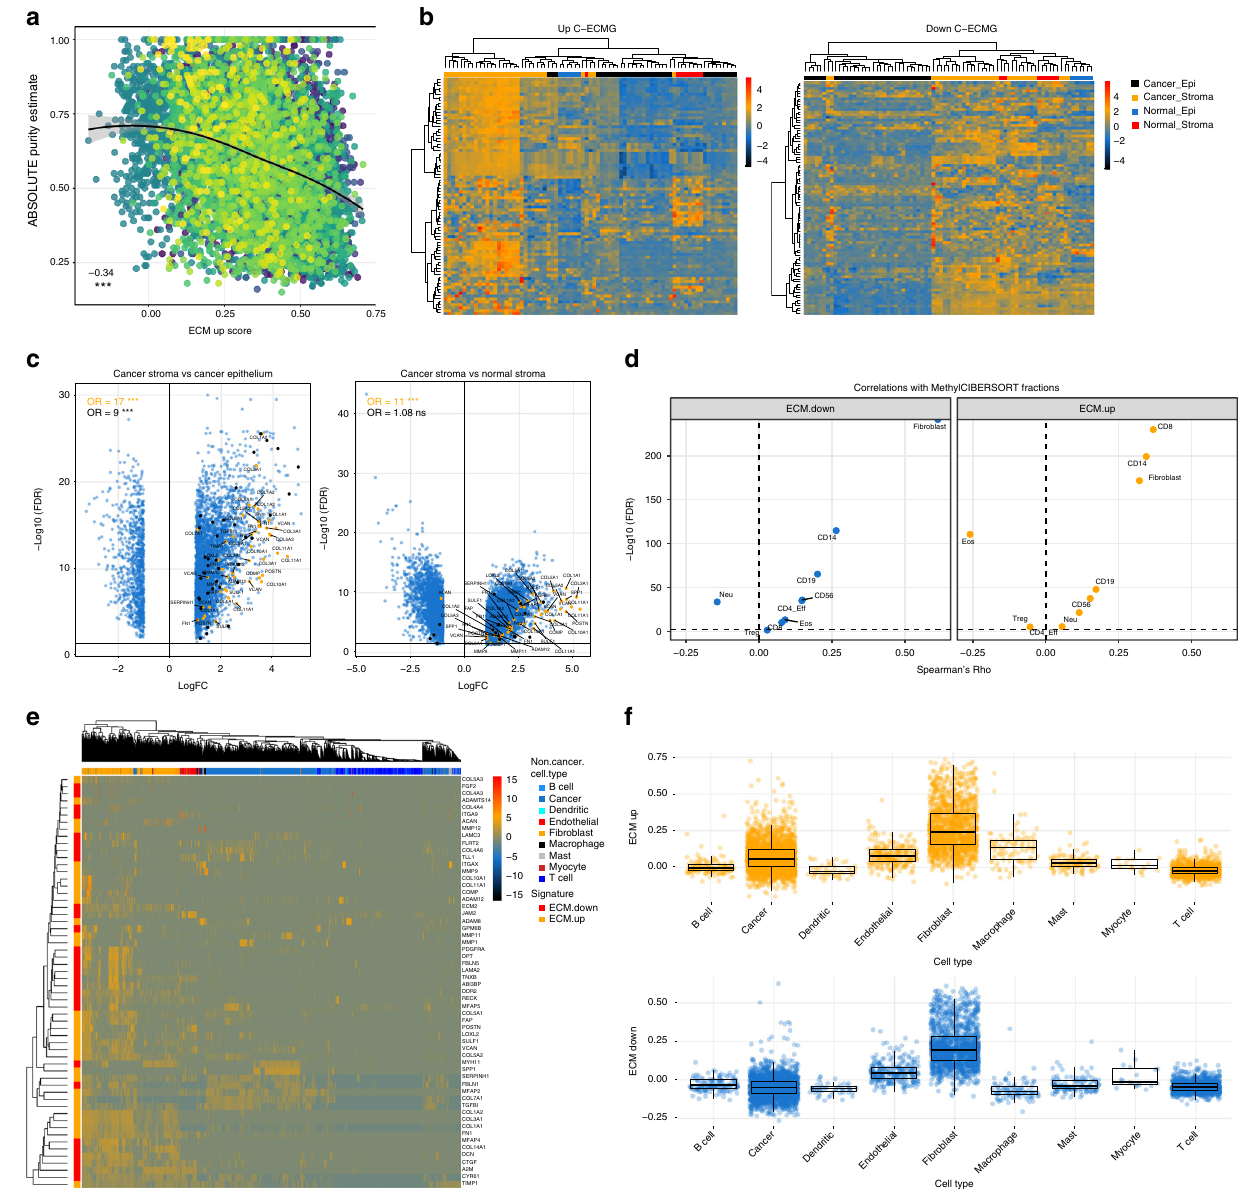
Fig. 2 C-ECM transcription is associated with stroma, especially CAFs. a ABSOLUTE purity estimates are inversely correlated with C-ECM-up score, suggesting stromal origin; colours represent cancer types, number shows Spearman ’ s Rho ( n = 8128). b Heatmaps of C-ECM-up and -down signatures projected onto microdissected epithelium and stroma from ovarian cancers. Rows show expression z -scores, samples are in columns. Annotation bars indicate tissue type. c Volcano plots show C-ECM genes (upregulated in orange, downregulated in black) differentially expressed between cancer stroma and epithelium and between cancer and normal stroma. d Volcano plots showing Spearman ’ s correlations between MethylCIBERSORT cell-type fractions and C-ECM scores. e Heatmap of C-ECM genes in single-cell HNSCC RNA-seq data ( n = 5902). f CAFs show the highest expression of C-ECM genes relative to other cell types in single-cell HNSCC data. Numbers on scatterplots indicate Spearman ’ s Rho, asterisks indicate statistical signi fi cance. *** p < 0.001. On all volcano plots, y axis = − log 10 fold change, x axis = test statistic/fold change/Spearman ’ s Rho. On volcano plots, all enrichment statistics